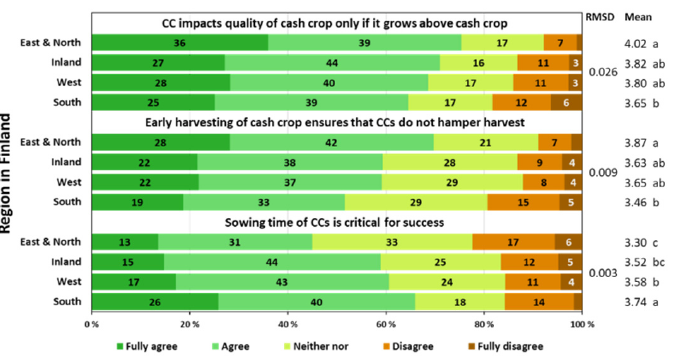
Figure 5. The distribution of farmers’ answers (N = 1130) depending on the region in Finland (RMSD, row mean scores difference; CCs, cover crops).